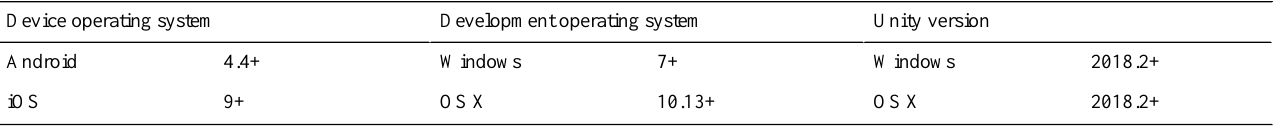
Table 1. Vuforia compatible mobile